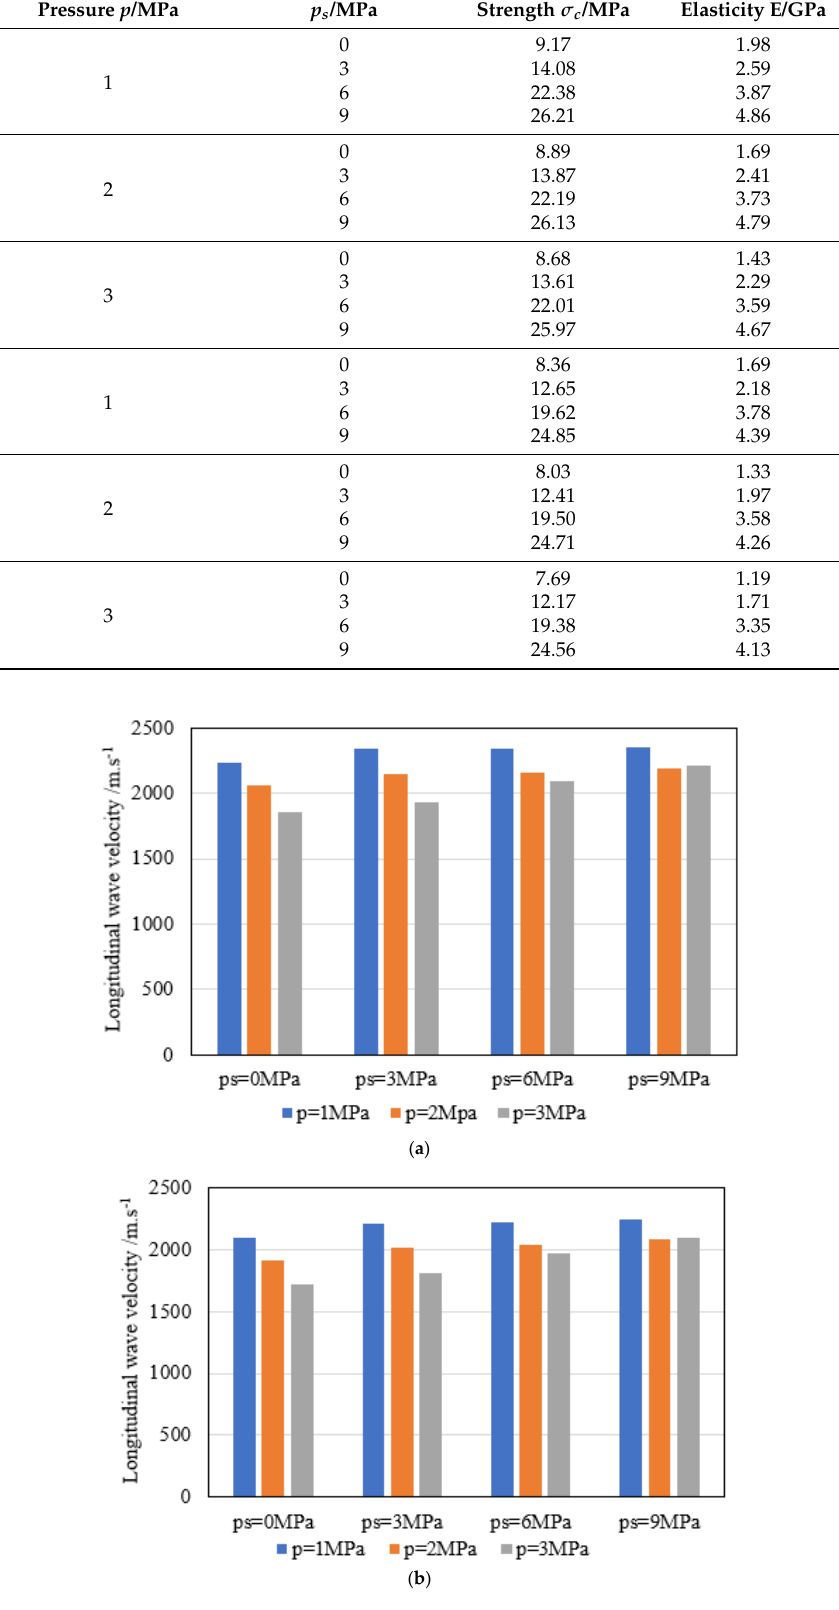
Figure 4. Longitudinal wave speed. ( a ) Meager coal. ( b ) Gas